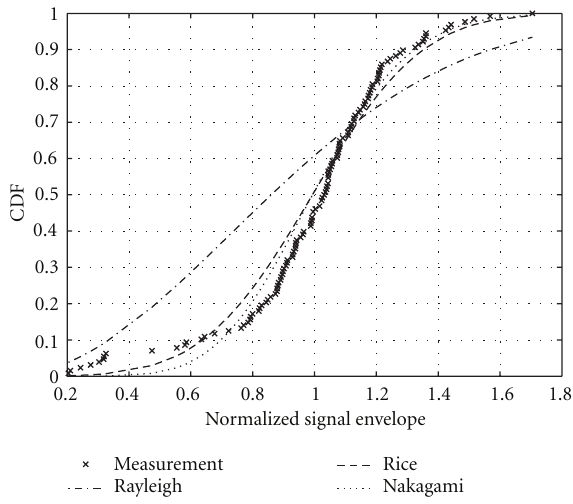
Figure 3: Sample empirical CDF of the small scale signal envelope and theoretical model fits for viaduct scenario. The Rice K factor is 5.56 and Nakagami parameter m is 4.37.